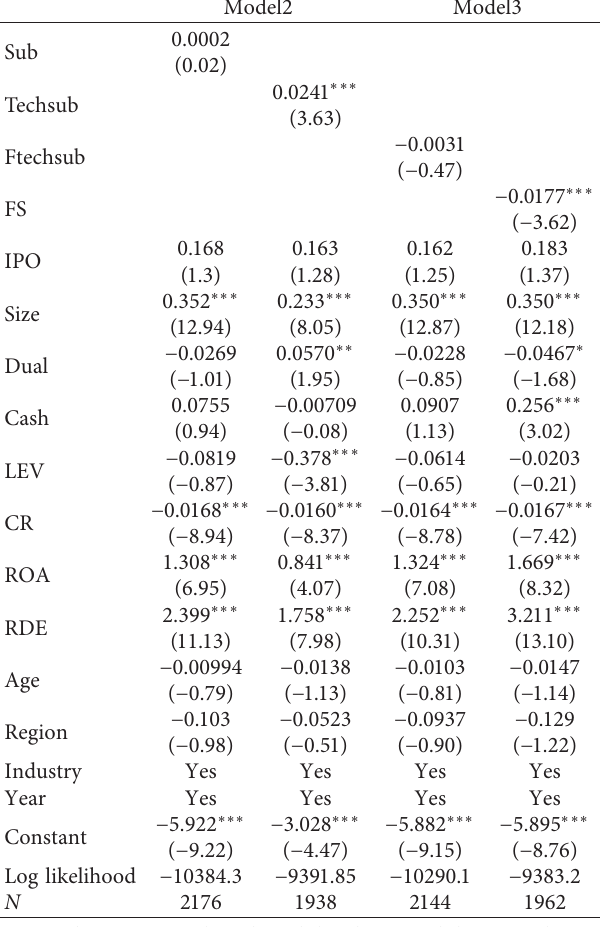
Table 4: Impact of government subsidy policy and financial support policy on entrepreneurial